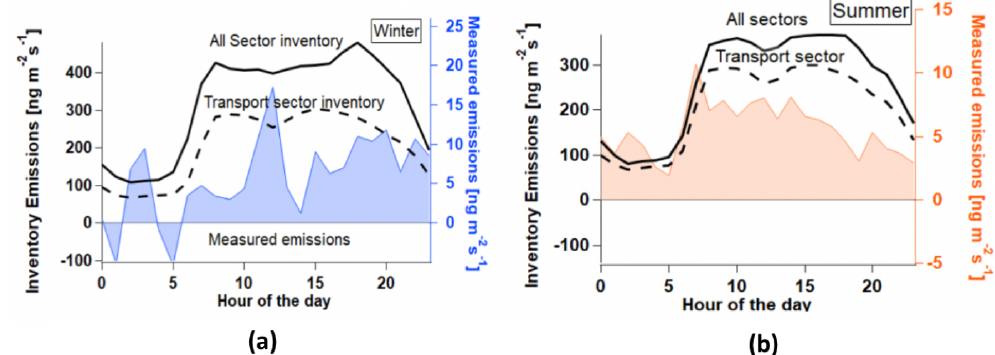
Figure 11. Comparison between measured emissions and the MEIC 2013 emission inventory for (a) winter and (b) summer for the flux footprint area (Sect. 4.3). Diurnal variation from the MEIC estimates is used for the diurnal cycles for emissions of all sectors (sum of emissions from transport, industry, residential and power) and the transport sector in